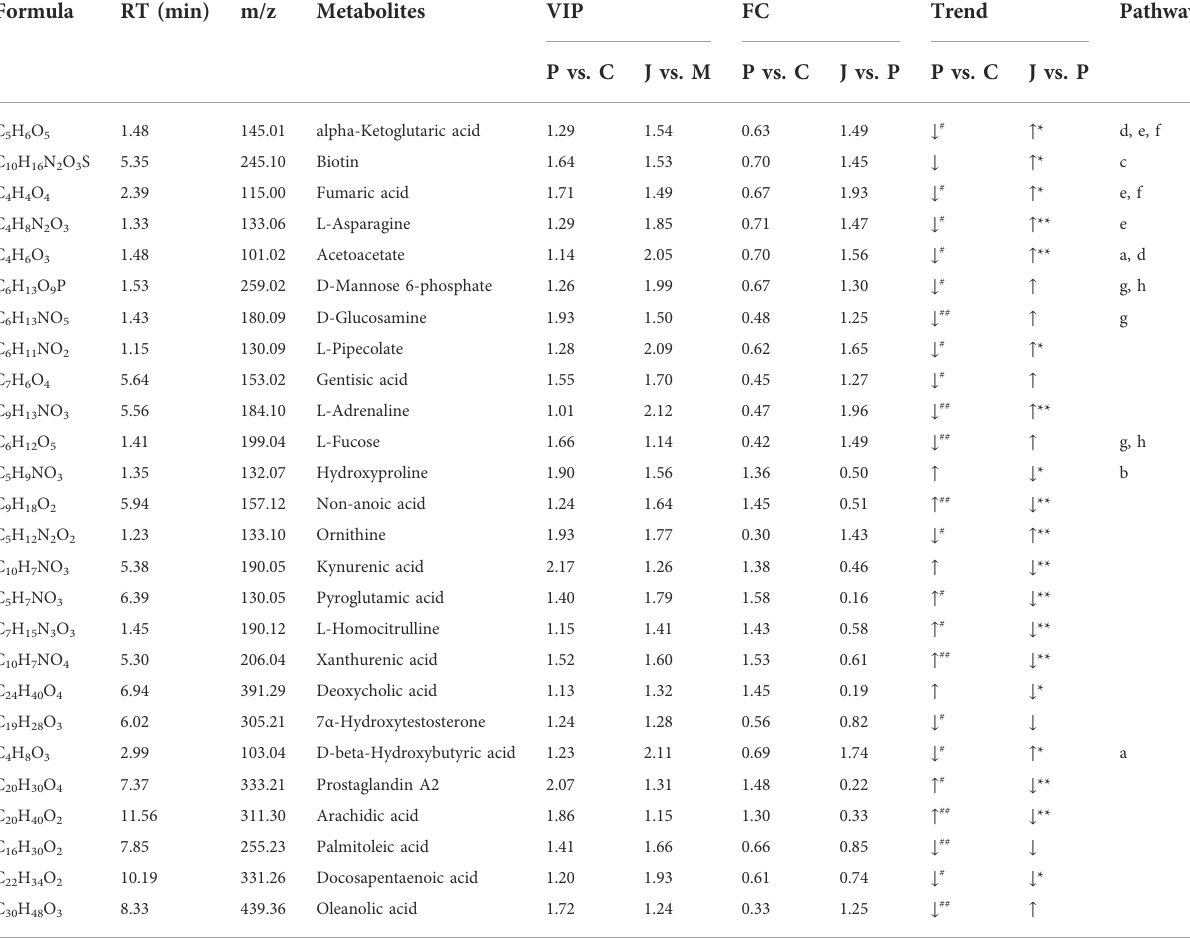
TABLE 5 Differential metabolites in poly(I:C)-induced viral pneumonia model mice after the treatment of JTKY. Formula RT (min) m/z Metabolites VIP FC Trend Pathway P vs. C J vs. M J vs.